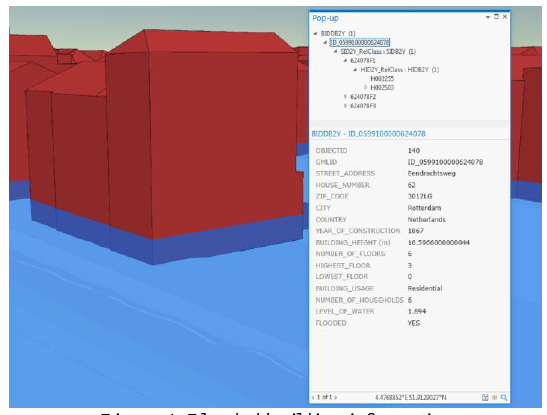
Figure 4. Flooded building